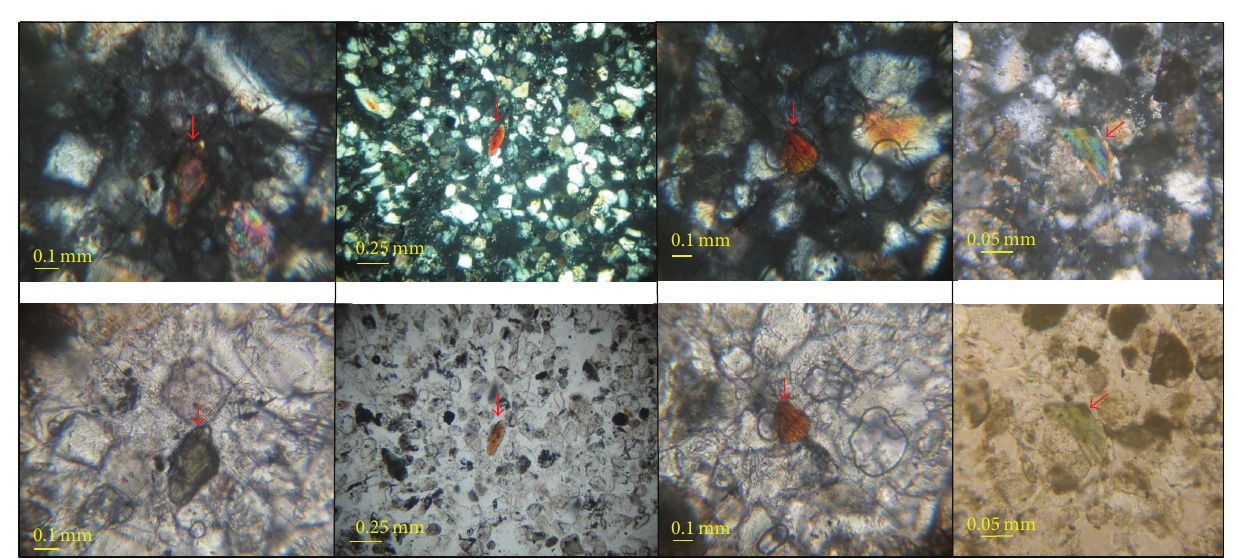
Figure 7: Biotite in matrix of quartz in AP spring’s